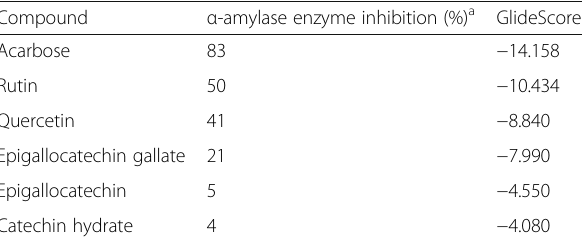
Table 7 The GlideScores and IC 50 values of acarbose and α -amylase inhibitors present in Elaeagnus umbellata